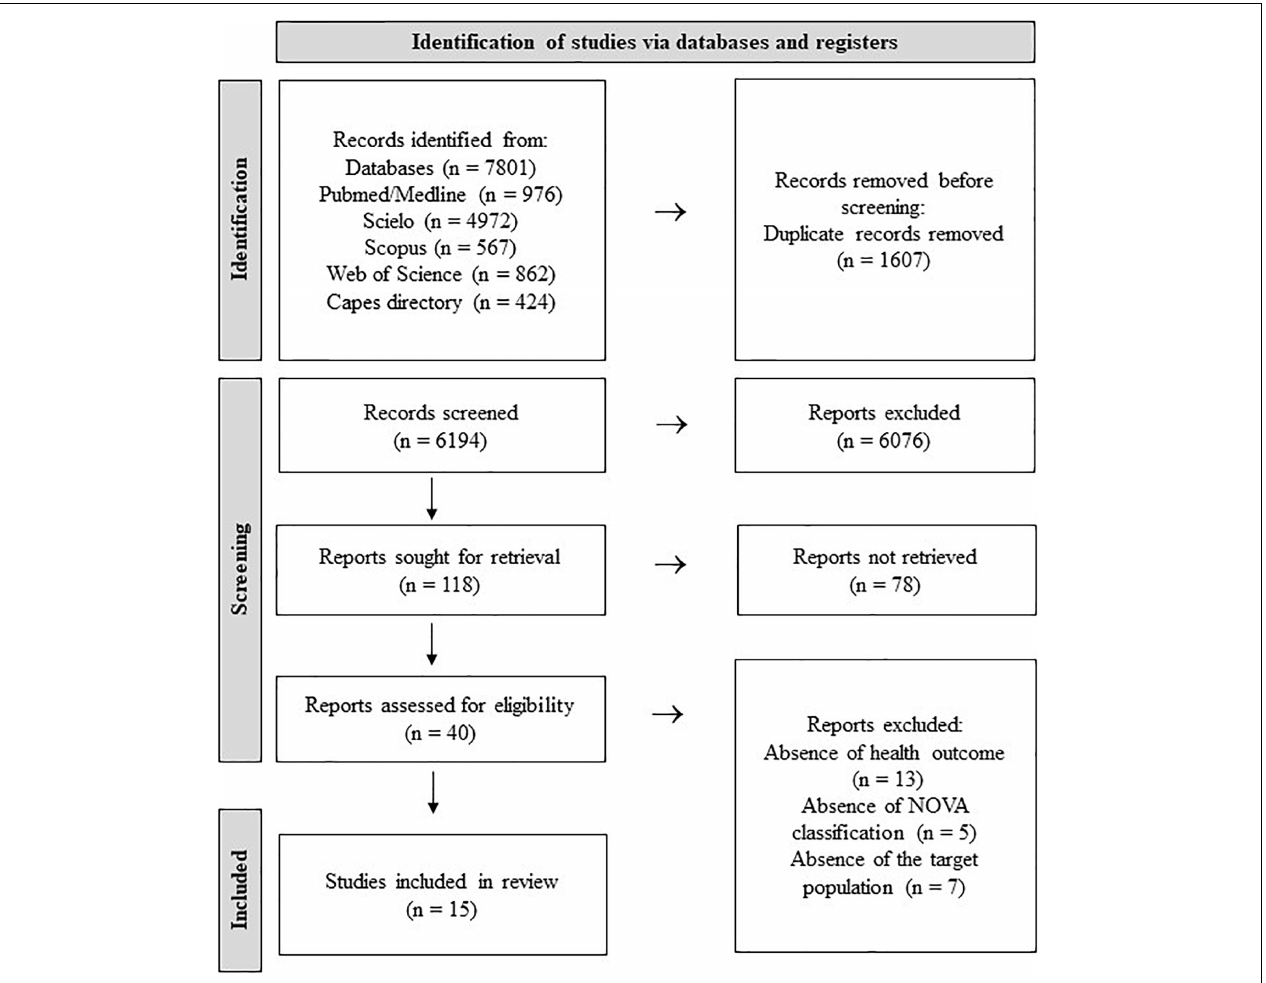
FIGURE 2 | Flow diagram of database search and article